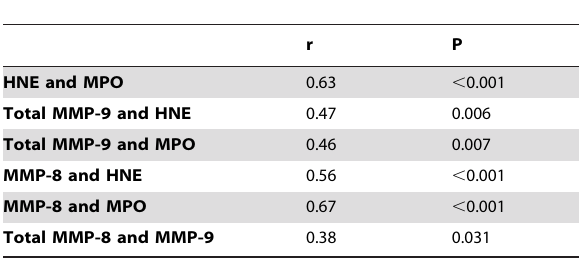
Table 2. Correlation coefficients for tracheal aspirate inflammatory markers at 48 hours of